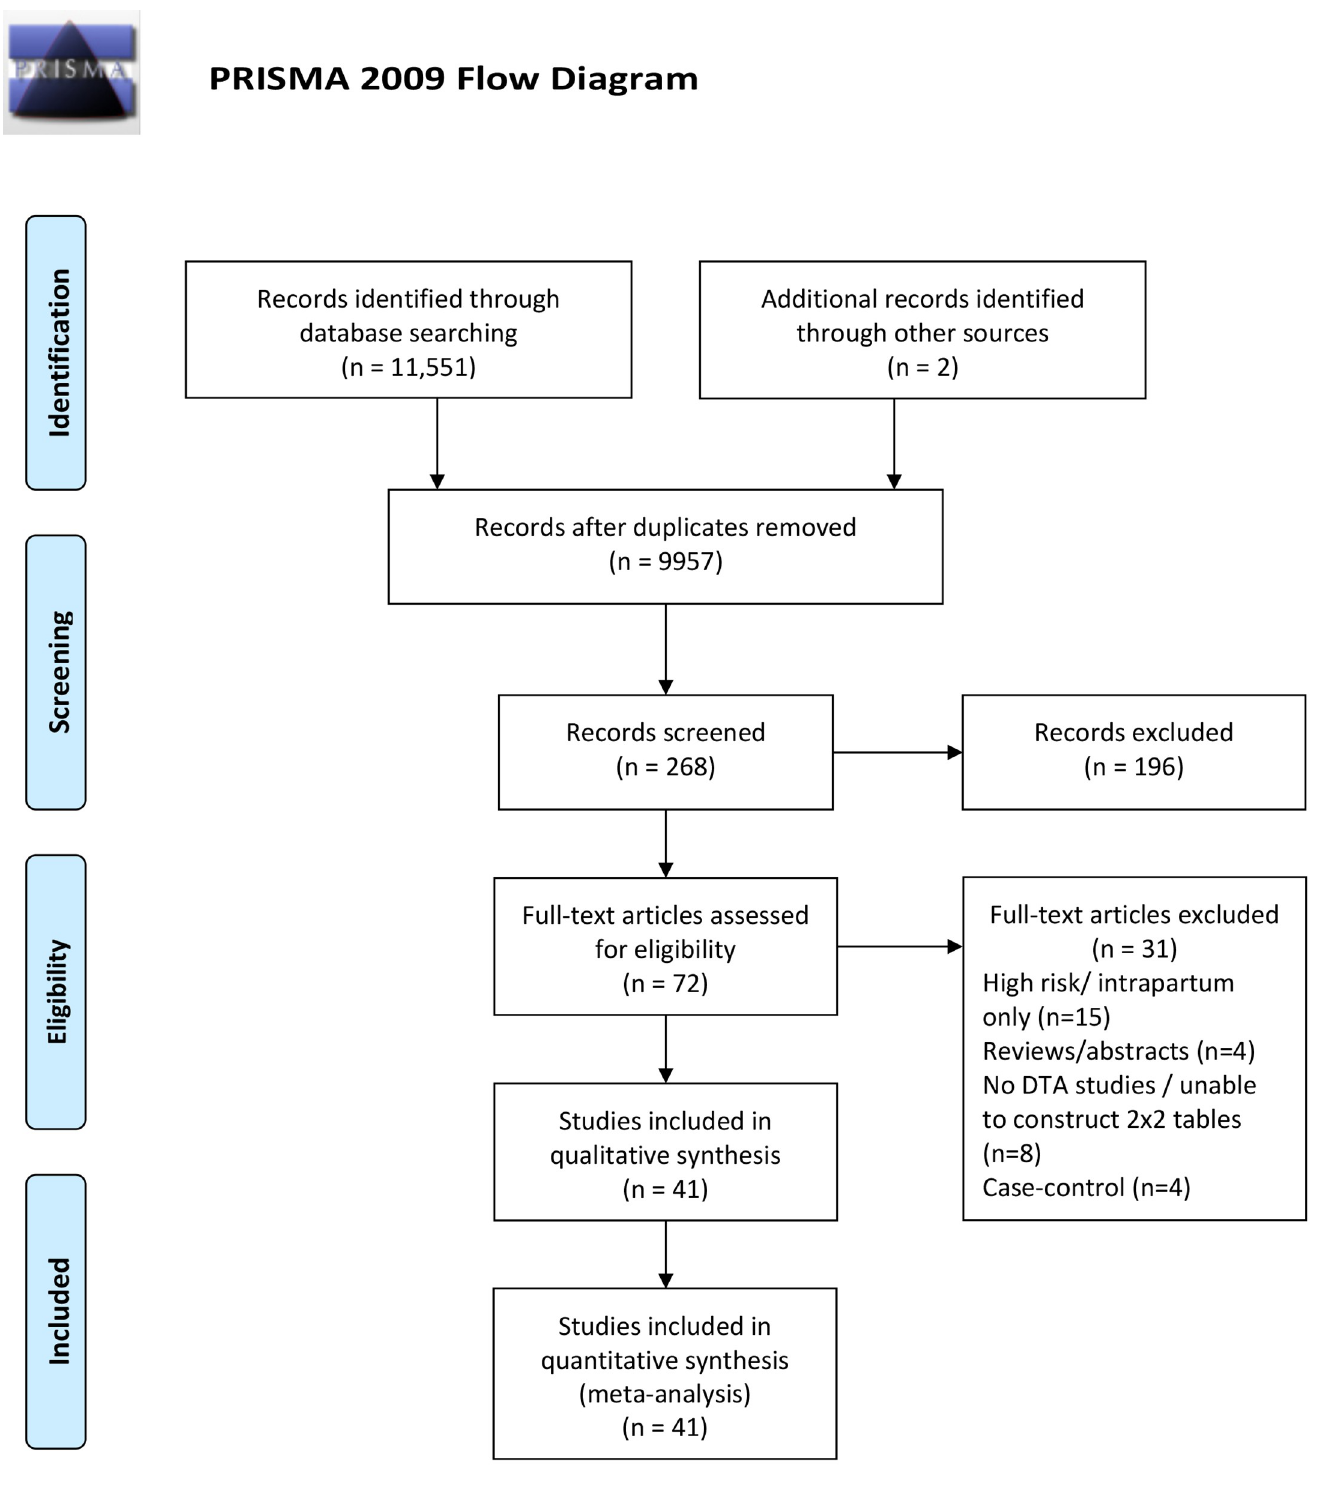
Fig 1. PRISMA flow